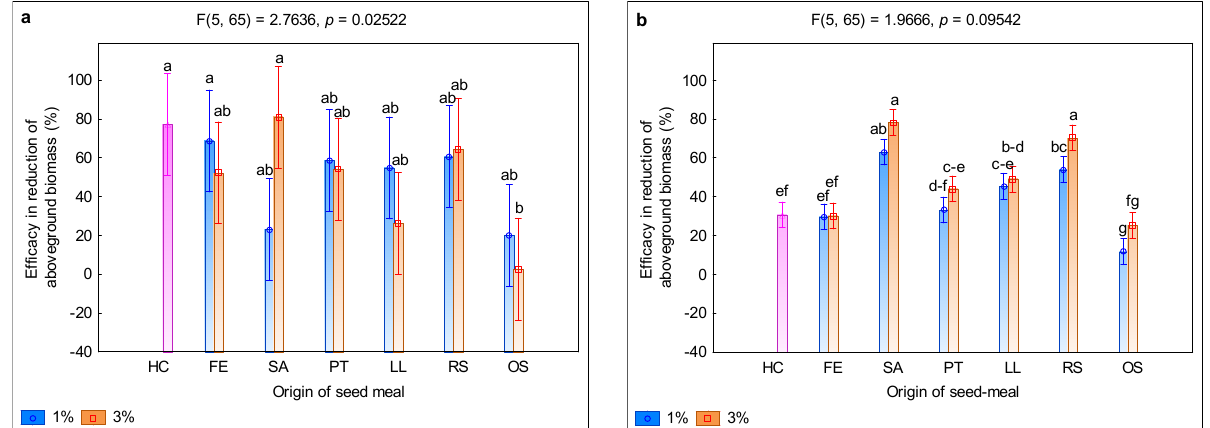
Figure 2. The mean efficacy in reduction in aboveground biomass of herbicide-susceptible ( a ) and -resistant ( b ) biotypes of wild oat depending on the origin of seed meals and their concentration. Means with various letters are significantly different, according to Tukey test ( p ≤ 0.05). Vertical bars mean 0.95 confidence intervals. The symbols mean HC—herbicide control, and seed meals from FE— Fagophyrum esculentum , SA— Sinapis alba , PT— Phacelia tanacetifolia , LL— Lupinus luteus , RS— Raphanus sativus , OS— Ornithopus sativus . The column colors mean pink—herbicide control, blue—1% concentration of seed meals, orange—3% concentration of seed meals.